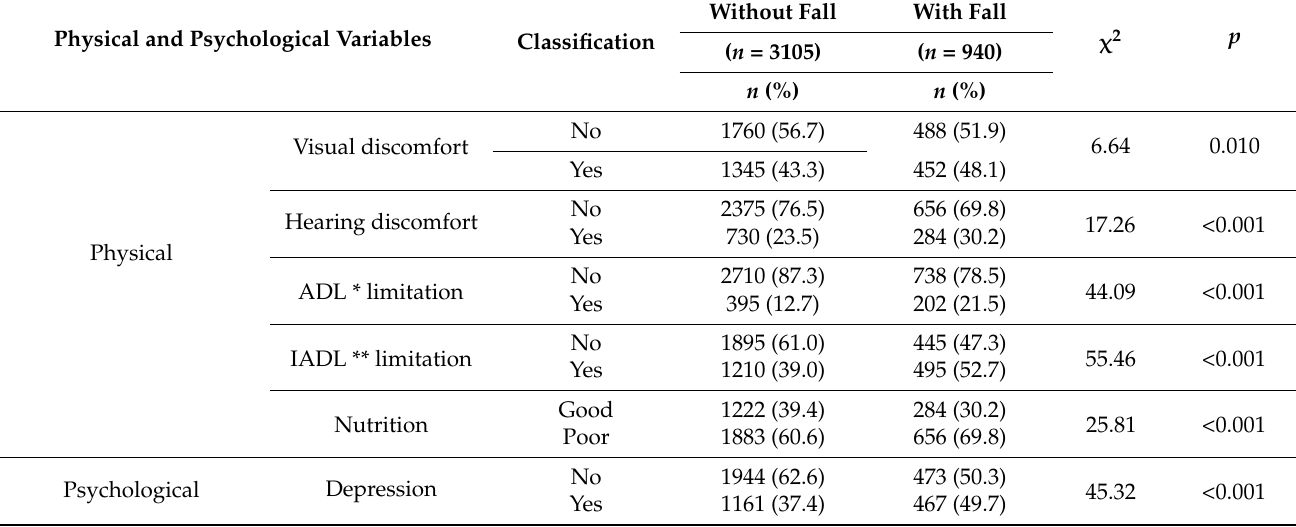
Table 2. Differences in physical and psychological characteristics between groups with and without fall history ( n = 4045).